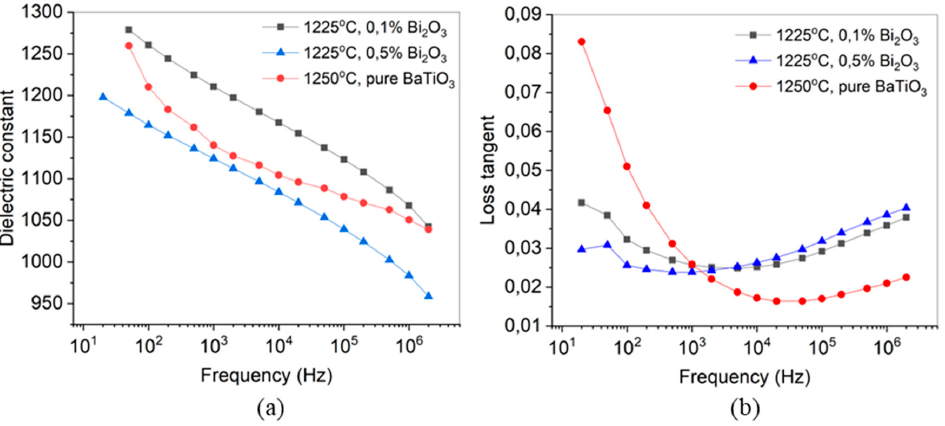
Figure 9. Dielectric constant ( a ) and loss tangent ( b ) vs. frequency for BaTiO 3 ceramics sintered under different conditions.